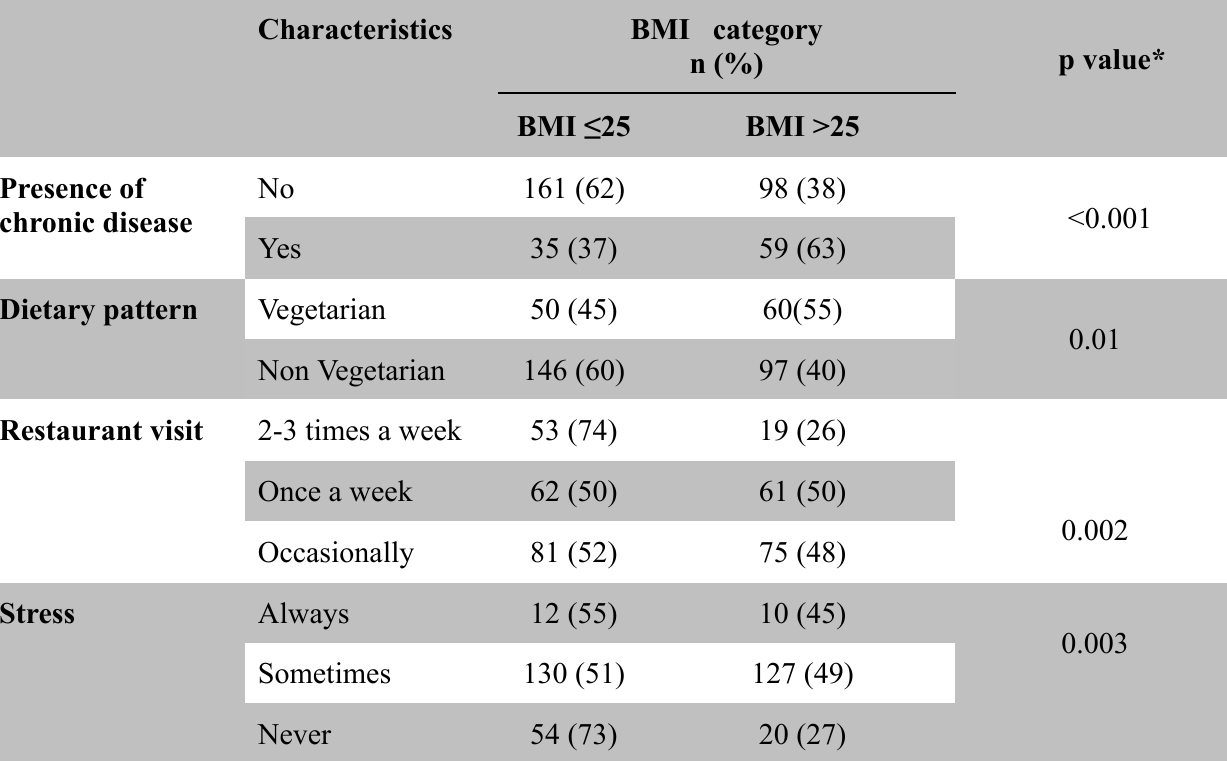
Table 5. Association of BMI with lifestyle related